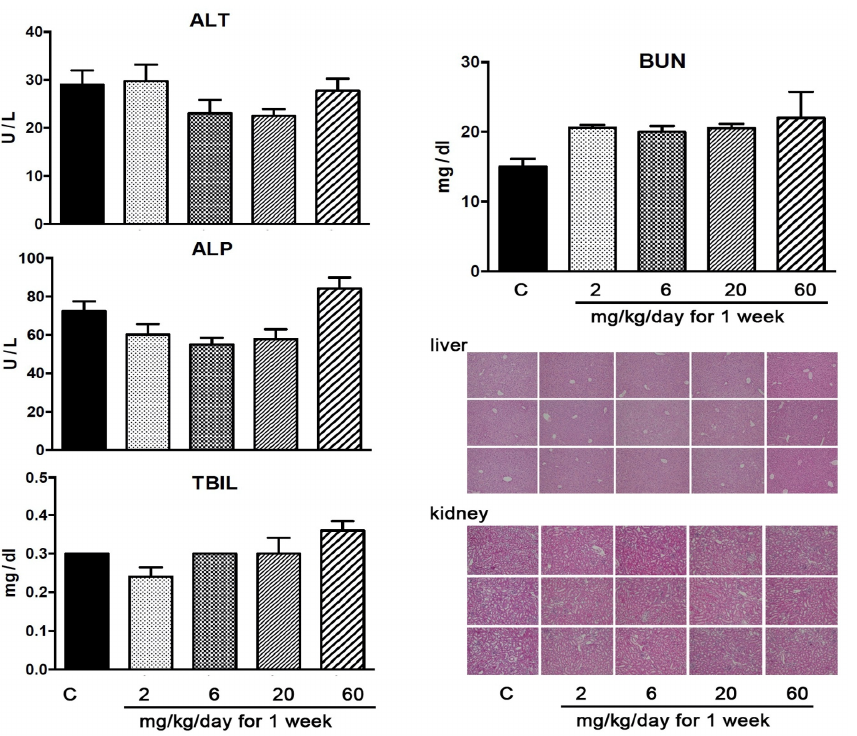
Figure 9. Effect of YD0251 treatment on plasma markers of organ damage and tissue histology. Mice were subjected to intraperitoneal injection of YD0251 in 2 divided doses (total daily doses: 2 mg/kg/day, 6 mg/kg/day, 20 mg/kg/day, and 60 mg/kg/day) for 7 consequent days (1 week). On the morning of the eighth day, the experiment was terminated, and blood was collected and analyzed by the Vetscan system (ALT: alanine aminotransferase; ALP: alkaline phosphatase; TBIL: total bilirubin; BUN: blood urea nitrogen). C: vehicle control group. The mean ± SEM of n = 5 mice per group is shown. In addition, there were no detectable histological alterations in any of the groups (representative H&E pictures are